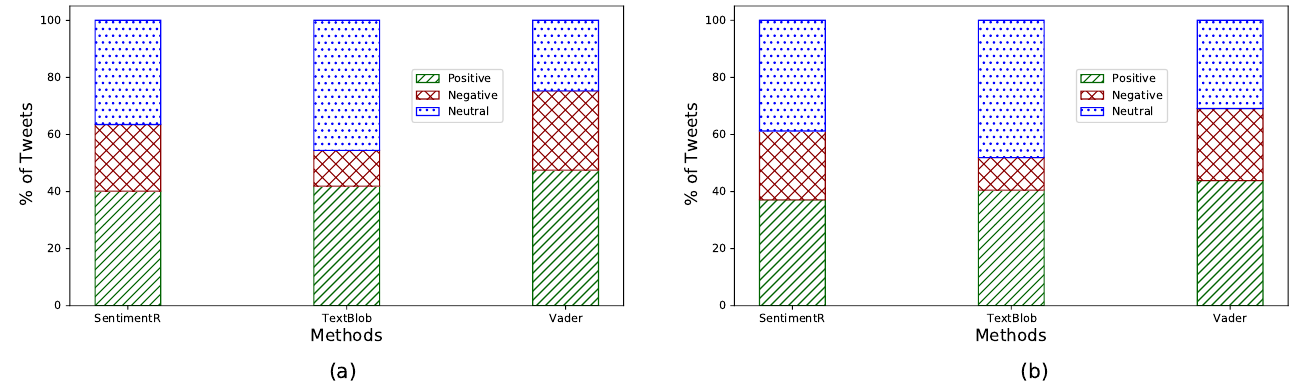
Figure 3. Sentiment classification using three different methods. ( a ) Tweets in early February 2021. ( b ) Tweets in late March